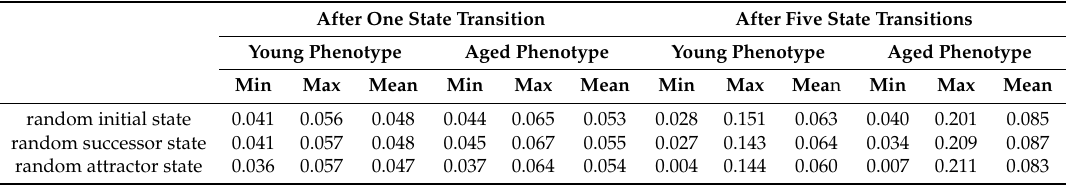
Table 1. Overview over the measured normalized Hamming distances of the young and aged phenotypes starting from random initial states, random successor states and random attractor states compared to perturbed networks after one and after five state